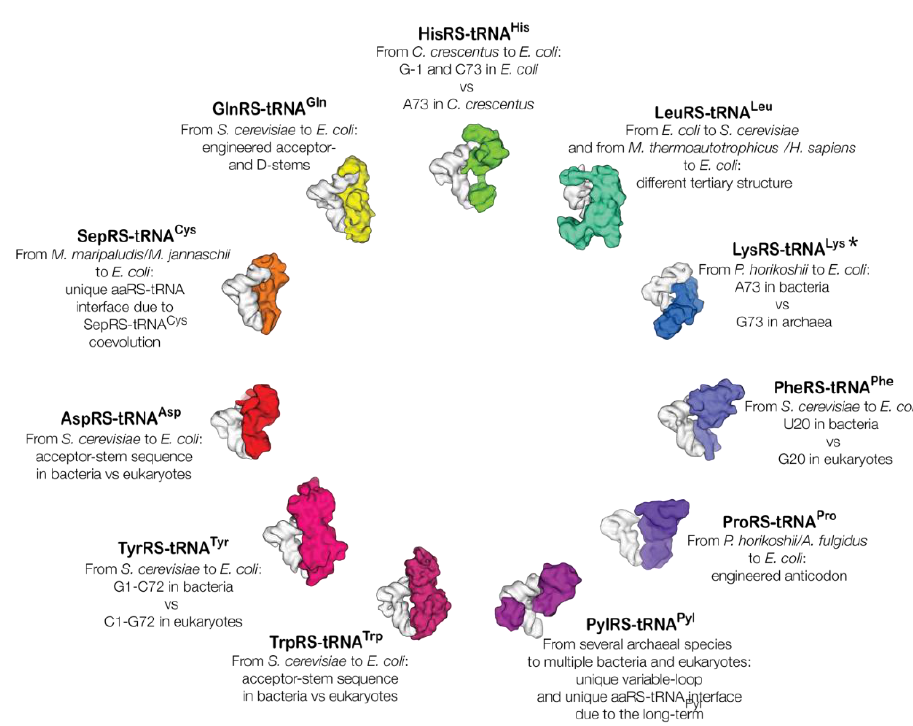
Figure 1. tRNA molecules and corresponding aminoacyl-tRNAs that have been used to expand the genetic code of live cells. Crystal structures of tRNA molecules (in white) are shown in complex with the corresponding aminoacyl-tRNAs (in the colors of the rainbow). The labels next to each structure indicate the origin of the orthogonal tRNA / tRNA synthetase pair and an organism into which this pair has been transplanted, which is followed by a brief description of tRNA identity or anti-identity elements that make a tRNA / tRNA synthetase pair orthogonal in an organism into which this pair has been transplanted. For example, the label “TyrRS-tRNA Tyr —From S. cerevisiae to E. coli : G1-C72 in bacteria vs C1-G72 in eukaryotes” means that the TyrRS-tRNA Tyr pair has been transplanted from S. cerevisiae into E. coli where this pair remains orthogonal due to di ff erent identity elements between bacterial and eukaryotic tRNA Tyr : the G1-C72 pair in bacterial tRNA Tyr and the C1-G72 pair in eukaryotic tRNA Tyr . The asterisk next to the LysRS-tRNA Lys complex indicates that this model was produced by docking the crystal structure of tRNA Lys into the tRNA-binding pocket of LysRS. The most comprehensive list of orthogonal tRNA / tRNA synthetase pairs and their classes can be found in the Supplemental files of Ref. [1].